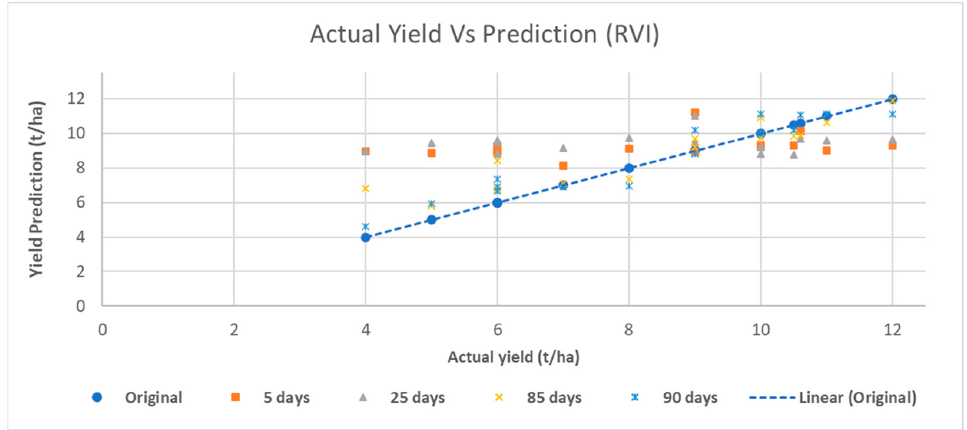
Figure 8. Scatter plot of actual yield vs. prediction of the four predictor dates.